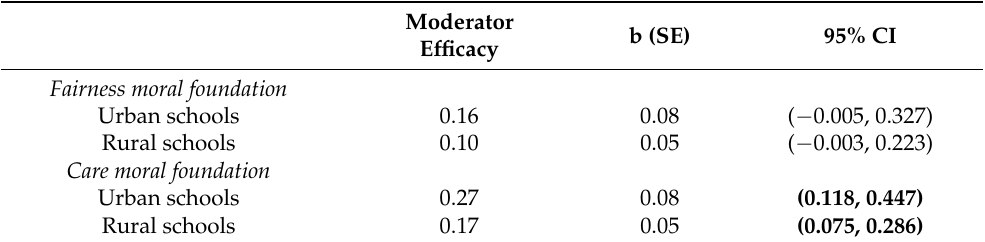
Table 5. Conditional Indirect effects of Critical Motivation on Altruistic Behaviour at Values of the Moderator.